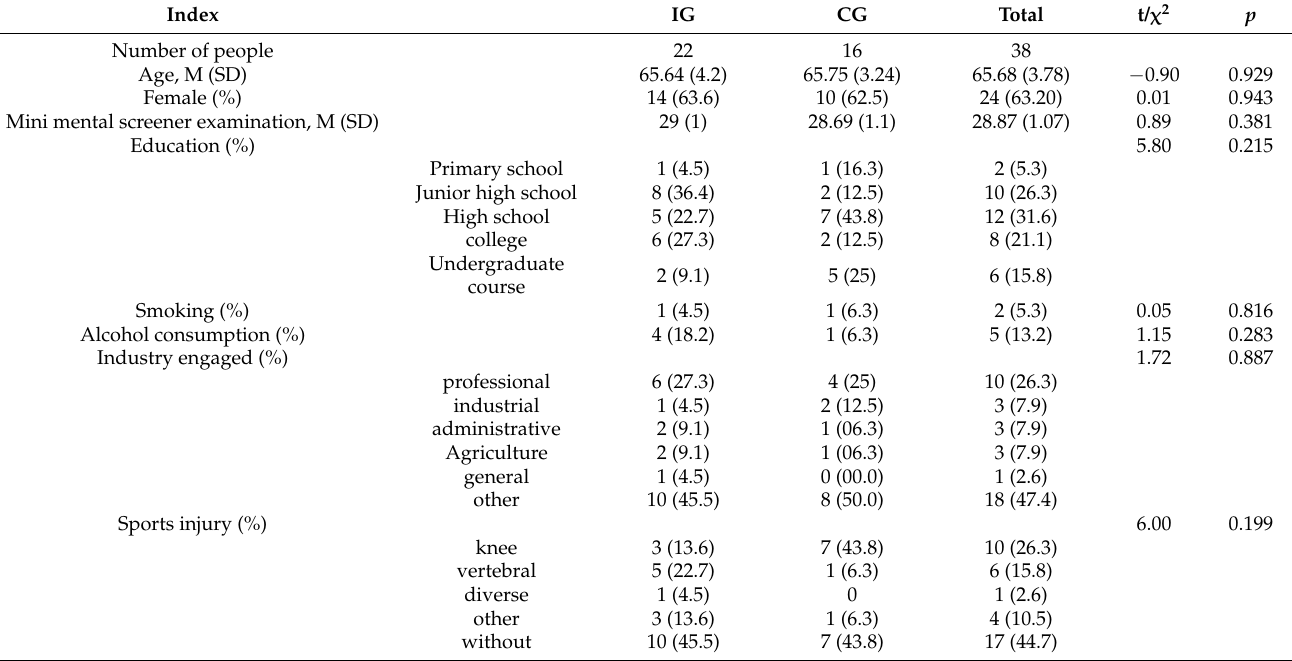
Table 1. Baseline demographic characteristics and screening values of the analyzed